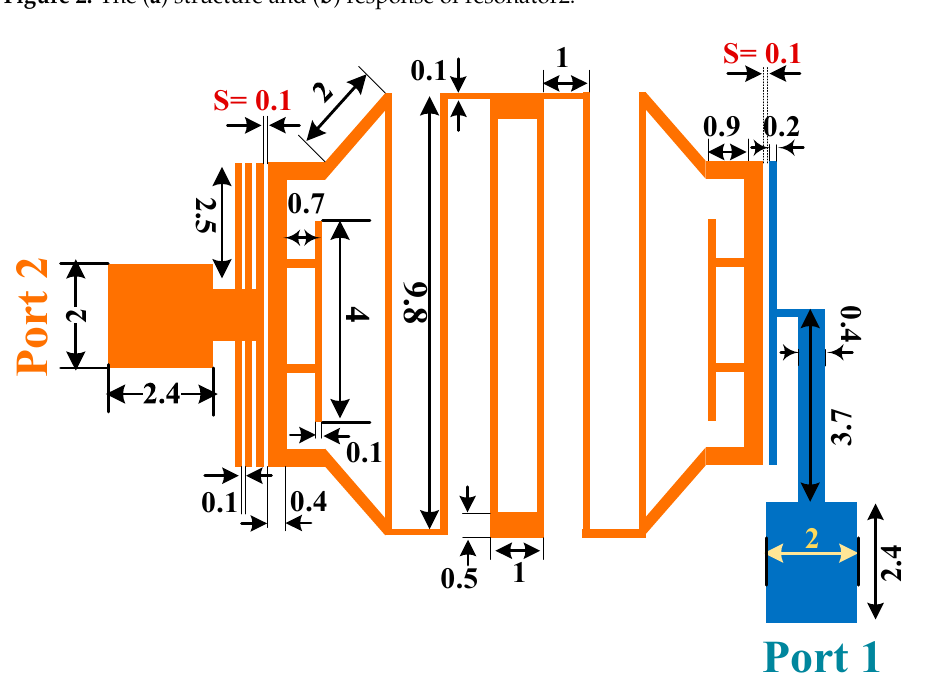
Figure 3. Structure of the first proposed BPF at 1.9/3.6 GHz. The simplified LC equivalent circuit for the first proposed BPF at 1.9/3.6 GHz